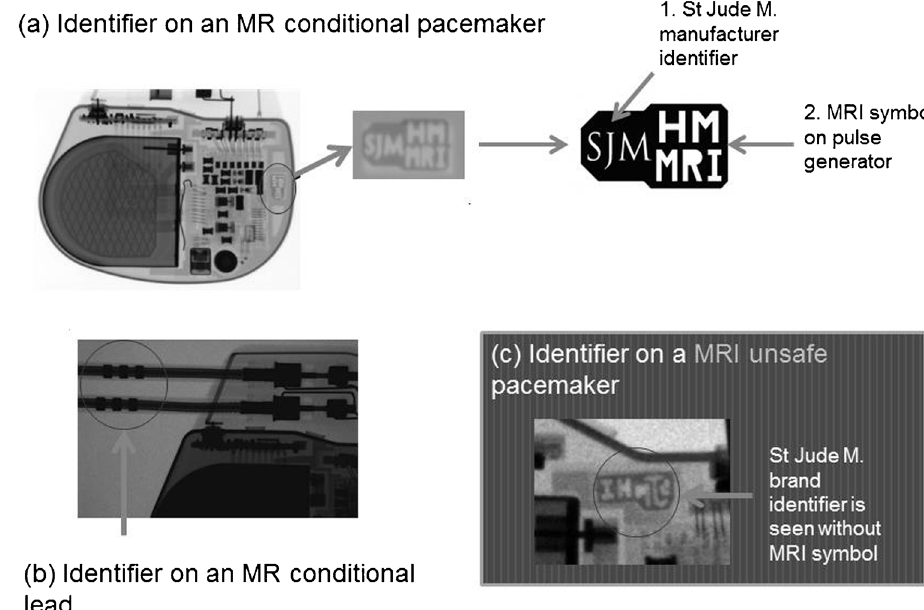
Fig. 6 Radiographic images (magnified) demonstrate identifi- er labels on a a MR conditional pacemaker (Accent ™ MRI, used with permission) b MR condi- tional lead (Tendril ™ , used with permission) c MRI unsafe pace- maker (Accent ™ , used with permission)